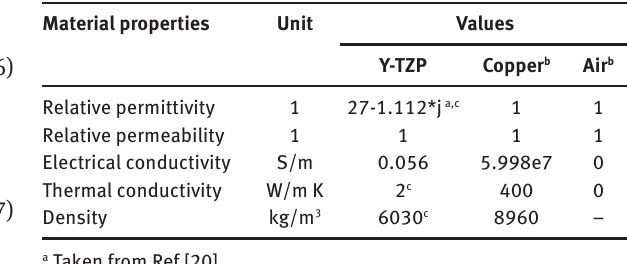
Table 3: Thermal and electric properties of Y-TZP used for simulation